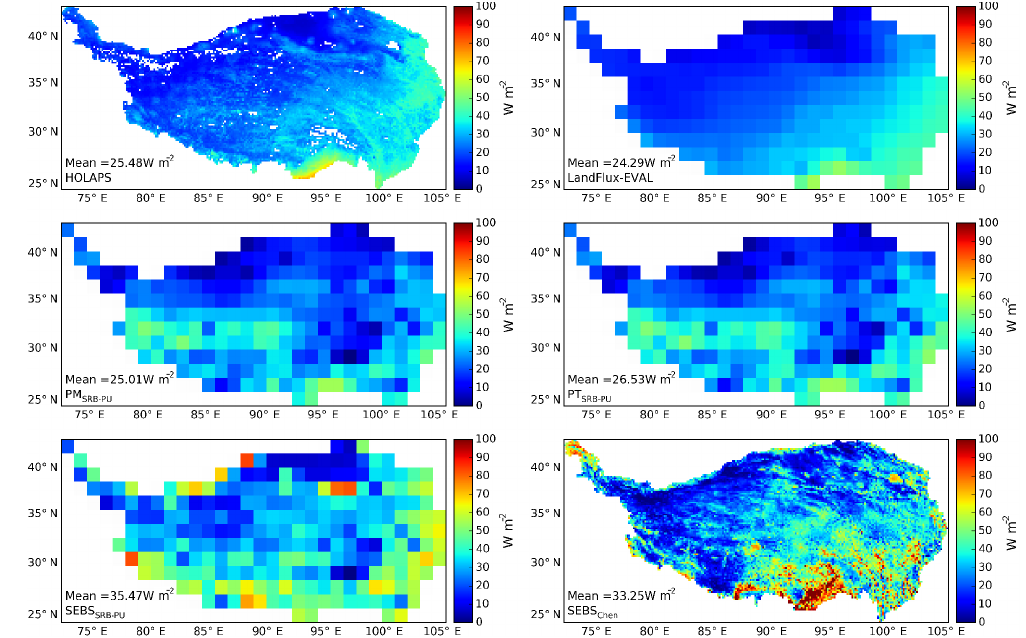
Figure 3. Spatial distribution of annual mean LE for each dataset over the